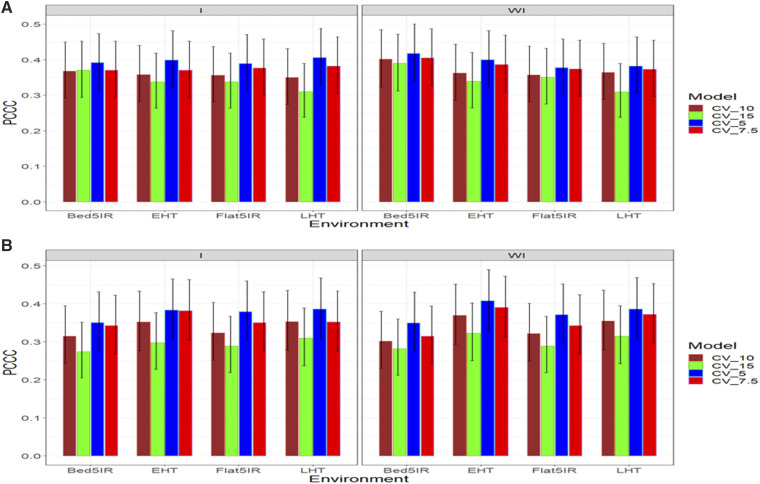
Prediction performance of the proposed MAPT model in terms of the proportion of cases correctly classified (PCCC) for traits: A) DTHD and B) DTMT of data set 1, under four values of coefficient of variation (CV). The smaller the CV, the more informative the prior. The left panel is with interaction (I) and the right panel is without interaction (WI).